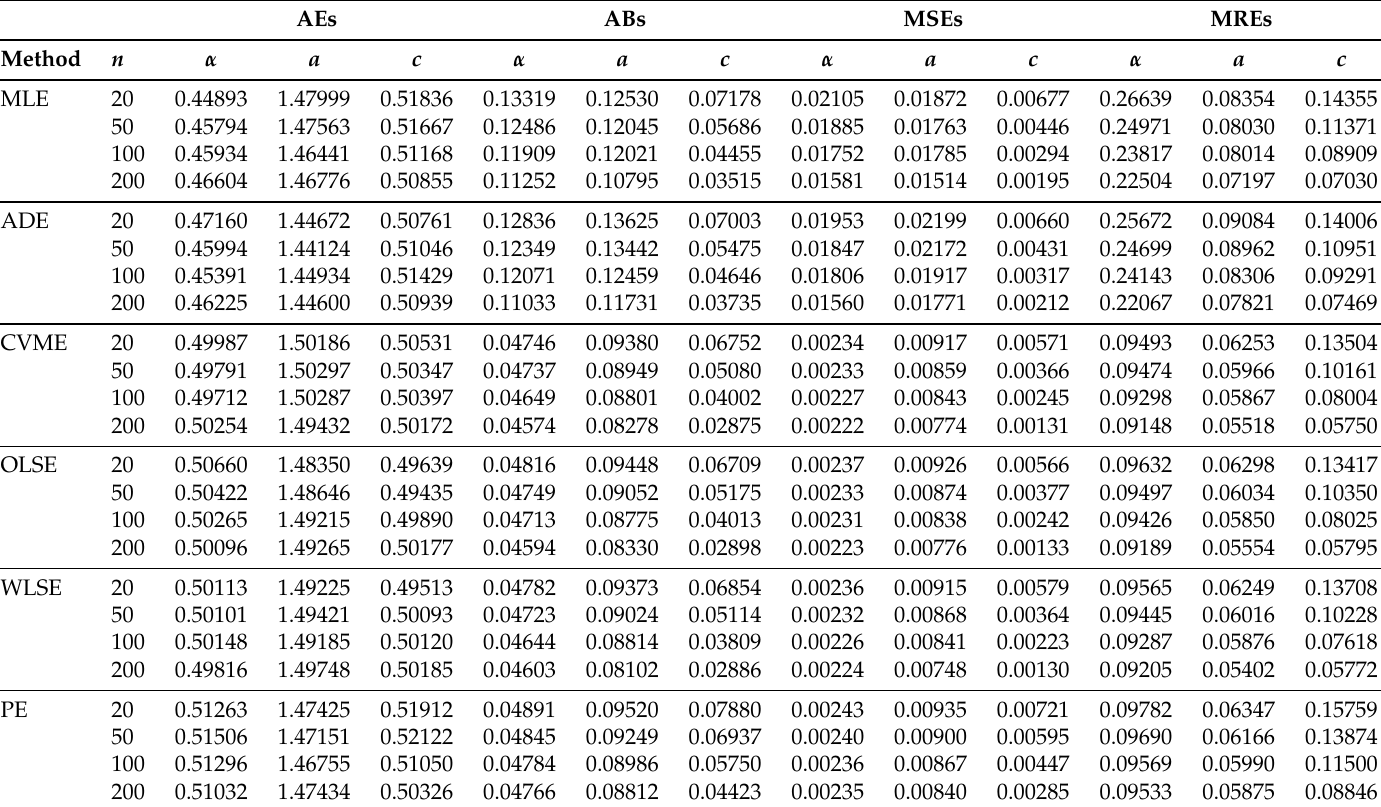
Table A5. The AEs, ABs, MSEs, and MREs for ( α = 0.5, a = 1.5, c = 0.5 )